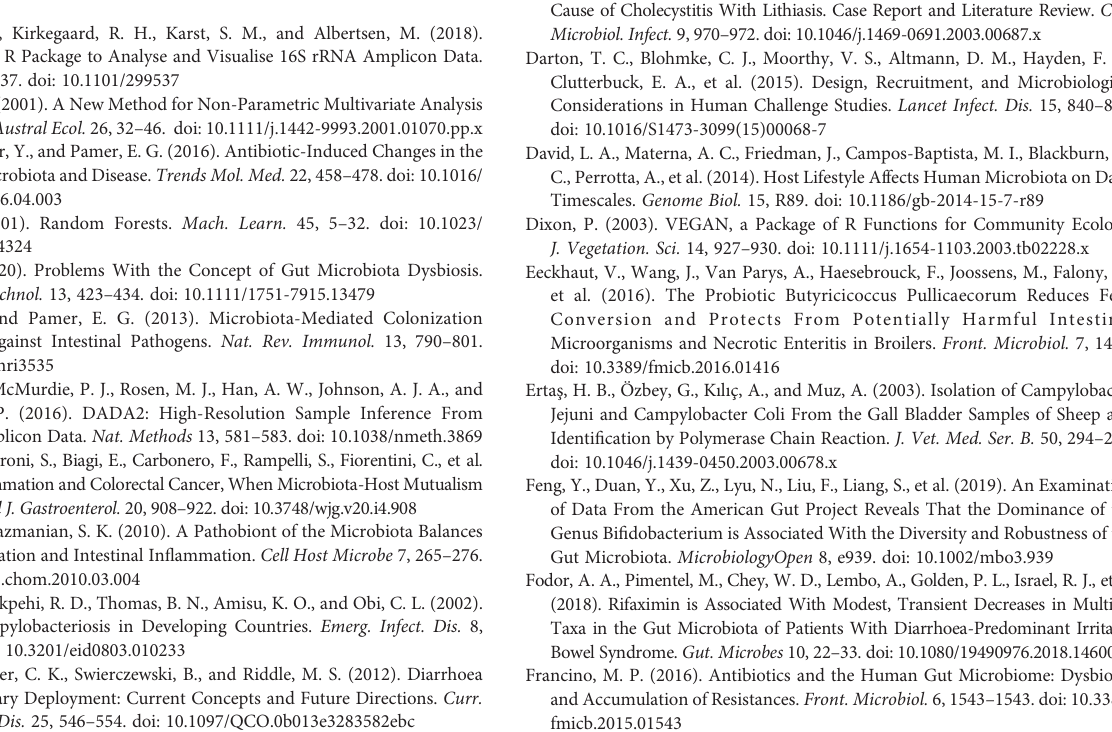
Supplementary Table 3 | Tableofthe top50 ASVs sorted by adecrease in mean accuracy of the generated random forest model. ASV taxonomy is given alongside mean Gini decrease.